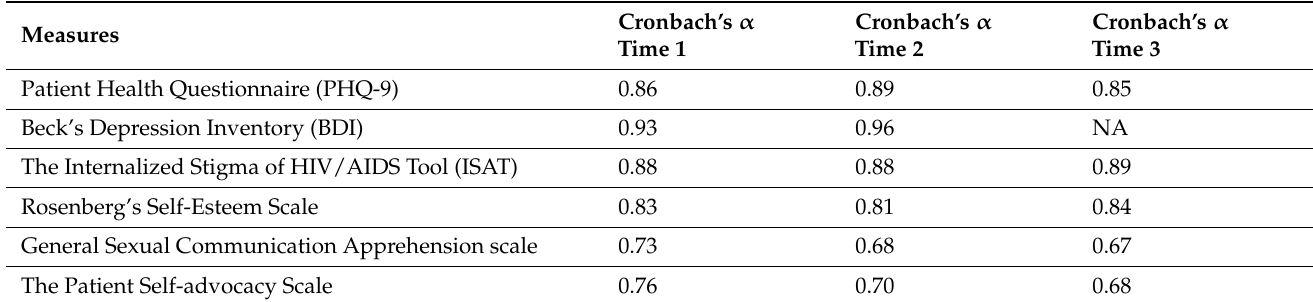
Table 2. Internal consistency for each